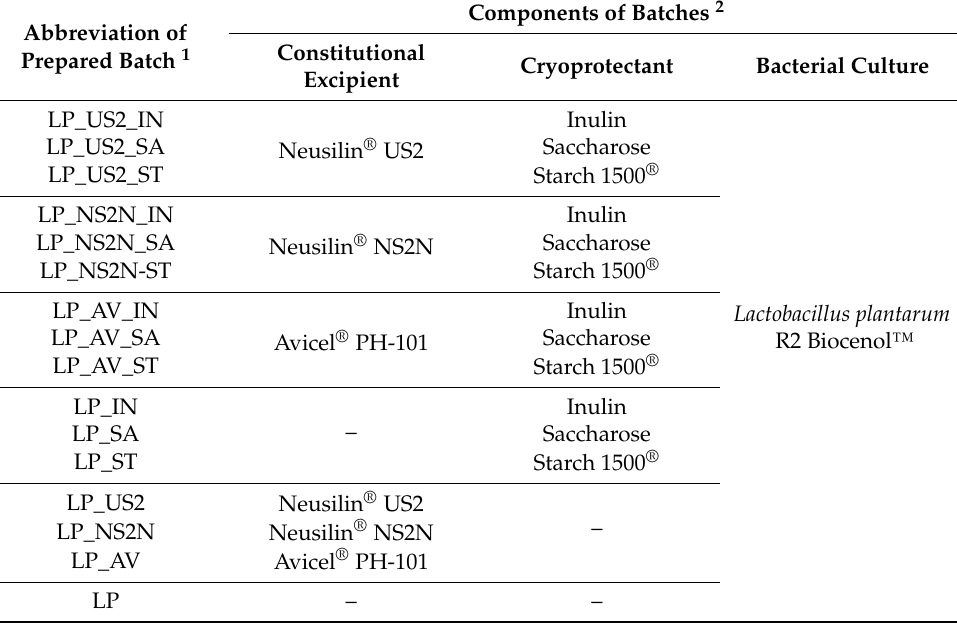
Table 1. Summary of prepared bacterial batches (abbreviation; composition of